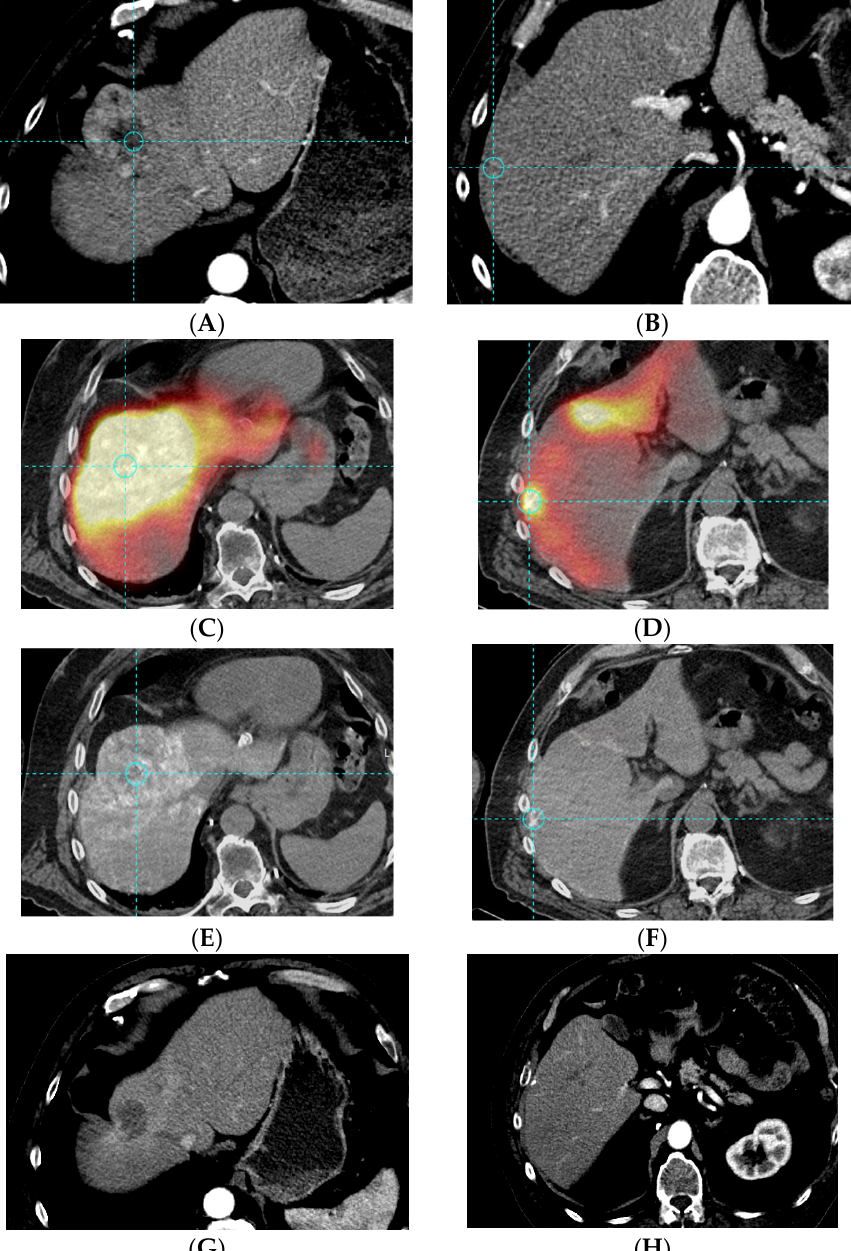
Figure 2. Case of a 70-year-old patient, BCLC B, with progressive disease after sorafenib, Child–Pugh A5, ECOG 0, treated with 3.44 GBq of 188 Re-SSS lipiodol using a whole liver approach. Baseline CT scan: lesion of 7 cm of segment VIII and IV (( A ), dotted line and circle), second lesion of 1 cm of segment V/VI (( B ), dotted line and circle), no PVT 188 Re-SSS lipiodol SPECT/CT at 24 h: very high tumor uptake ( C , D ) and high lipiodol retention ( E , F ) of the main lesion and of the small satellite lesion, as well four months post-injection: good partial response of the main lesion ( G ) and complete response ( H ) of the satellite lesion (with only residual lipiodol retention). Global overall survival was 31 months after